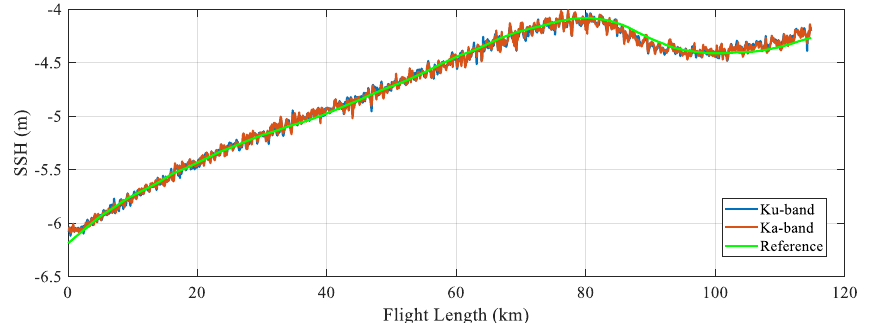
Figure 13. Verification of dual-band SSH retrieval results. The blue curve is the SSH data of Ku-band retrieval, the red curve is the SSH data of Ka-band retrieval, and the green curve is the public SSH data along the flight path at the experiment day.